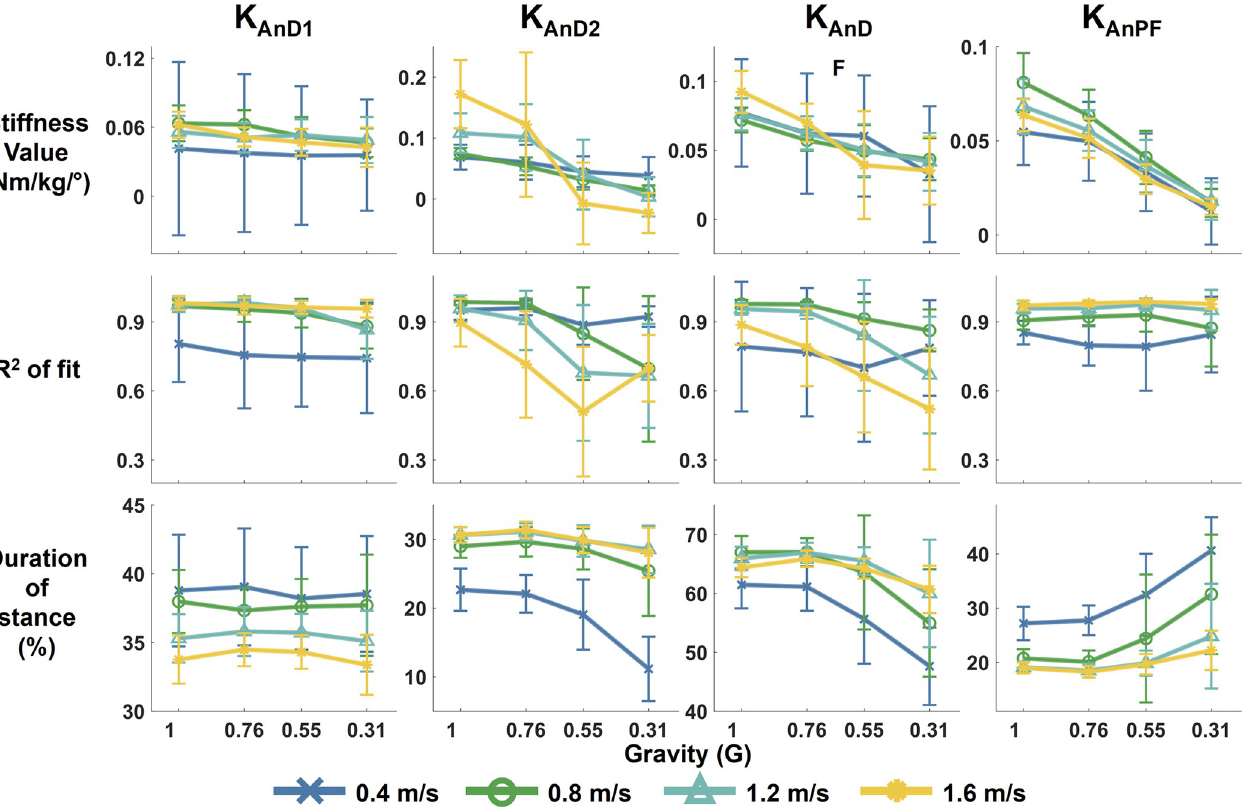
Fig 5. Quasi-stiffness of the ankle in stance phase at different levels of simulated reduced gravity and speeds. Top row shows stiffness values, middle row is the quality of fit of the linear quasi-stiffness model, and bottom row is the duration of the quasi-stiffness phase as percent of stance phase. Each column of plots is a different quasi-stiffness phase for the ankle: K AnD1 is early dorsi-flexion, K AnD2 is Ankle late dorsi-flexion, K AnDF is overall Ankle dorsi-flexion, and K AnPF is Ankle plantar-flexion. The error bars represent standard